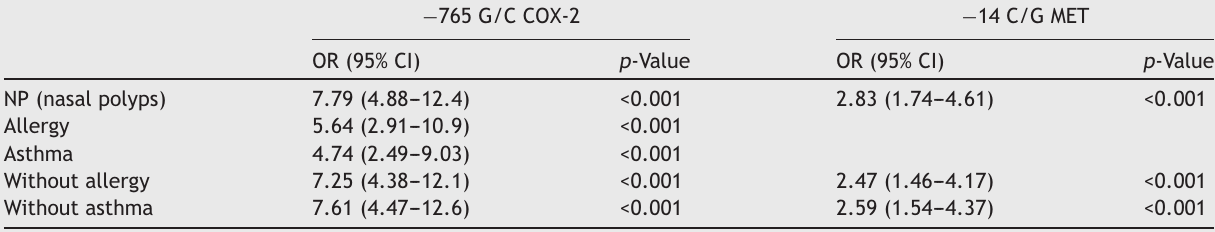
Odds ratio (OR) and 95% confidence intervals (CI) for the association between COX-2 and MET gene polymorphisms and nasal polyps (NP) phenotypes with and without allergy or asthma.